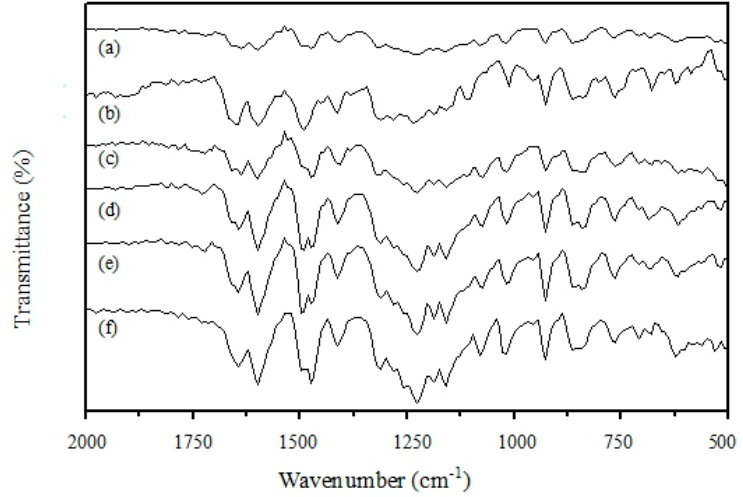
Figure 4. FTIR spectra for the sulfonated PEEK samples with different degrees of sulfonation: ( a ) 0%, ( b ) 41%, ( c ) 49%, ( d ) 57%, ( e ) 66%, and ( f ) 68%.